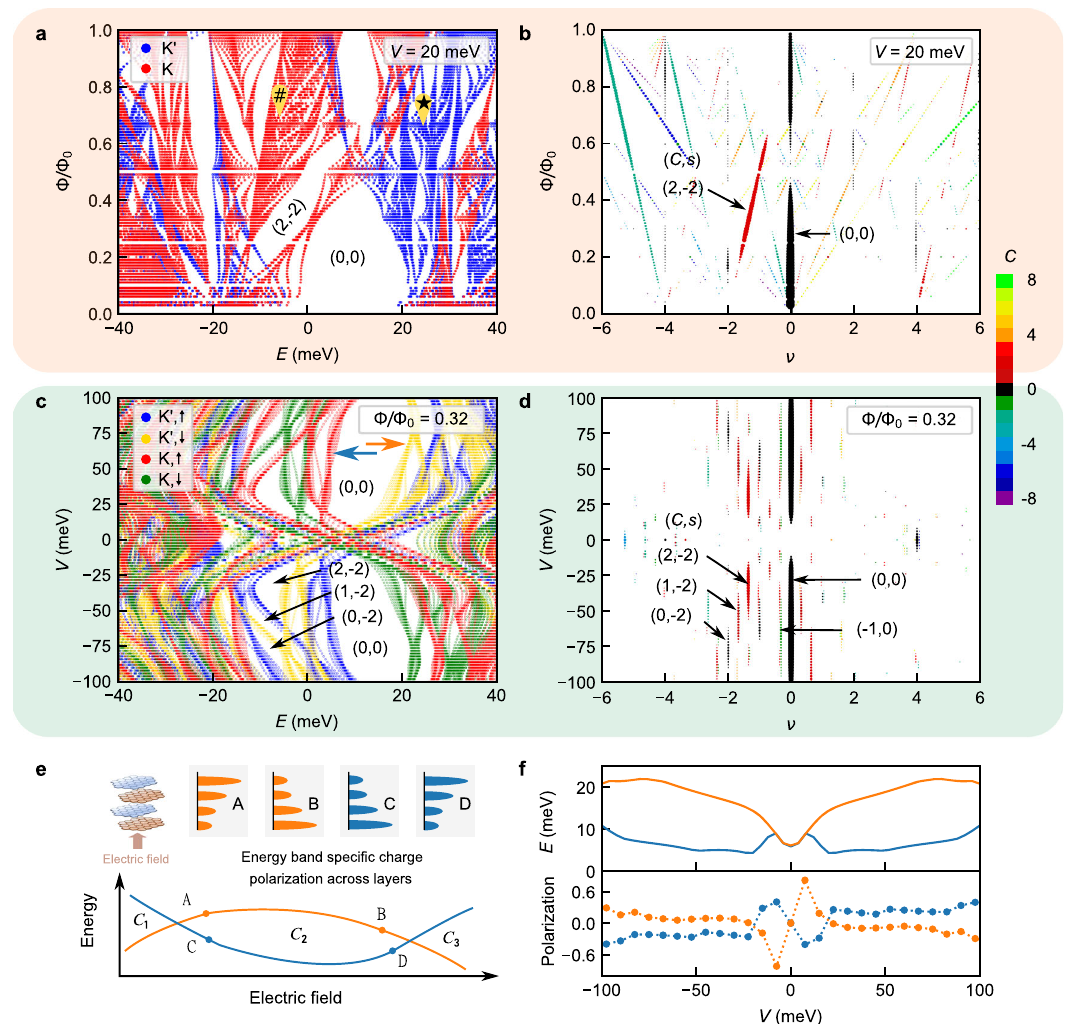
Fig. 3 | Calculation of Hofstadter spectra and layer polarization in TDBG. a Calculated Hofstadter energy levels for both K and K 0 valleys in TDBG with twist angle 1.10 ∘ for an interlayer potential of V =20 meV. Energy levels disperse differ- ently for two valleys due to different topology resulting in fewer number of gaps-- e.g., energy gap for K valley at location ⋆ is fi lled with energy levels from K 0 valley (vice versa for location #). b Corresponding Wannier diagram showing the evolu- tion of Hofstadter gaps considering both the valleys as a function ν and Φ / Φ 0 . c Evolution of energy spectra as a function of interlayer potential V at a constant magnetic fi eld corresponding to Φ / Φ 0 =0.32~9T with an exchange enhanced Zeeman splitting of 2.5meV. This con fi rms the change in Chern numbers as sche- matically depicted in Fig. 2c. d Evolution ofgaps asa function of ν and V extracted from c . The width ofthe line segments in b and d are proportional to the values of